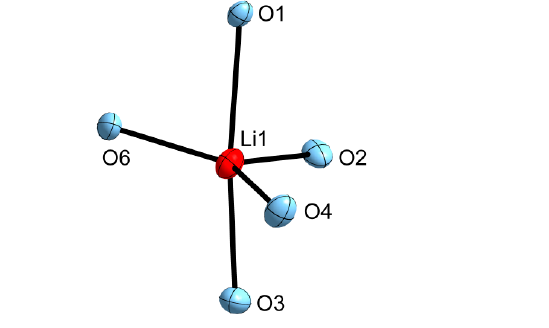
Figure 2. Trigonal bipyramidal coordination polyhedron of the lithium cation in [Li(1,2-disila[18]crown-6)]PF 6 ( 1 ).